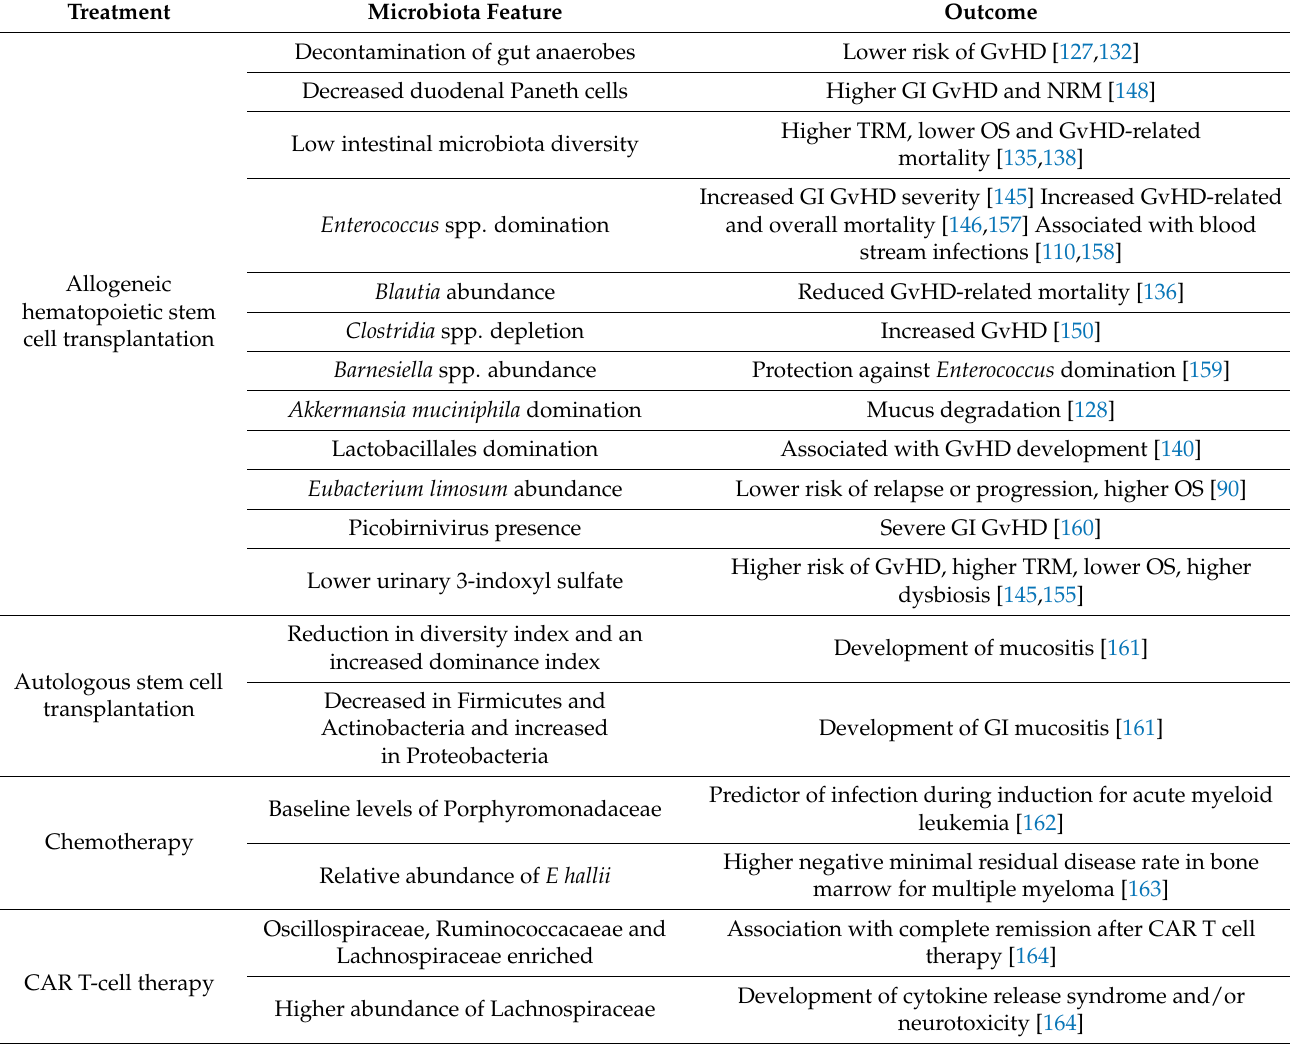
Table 2. Summary of outcomes induced by type of treatment and microbiota disruption in